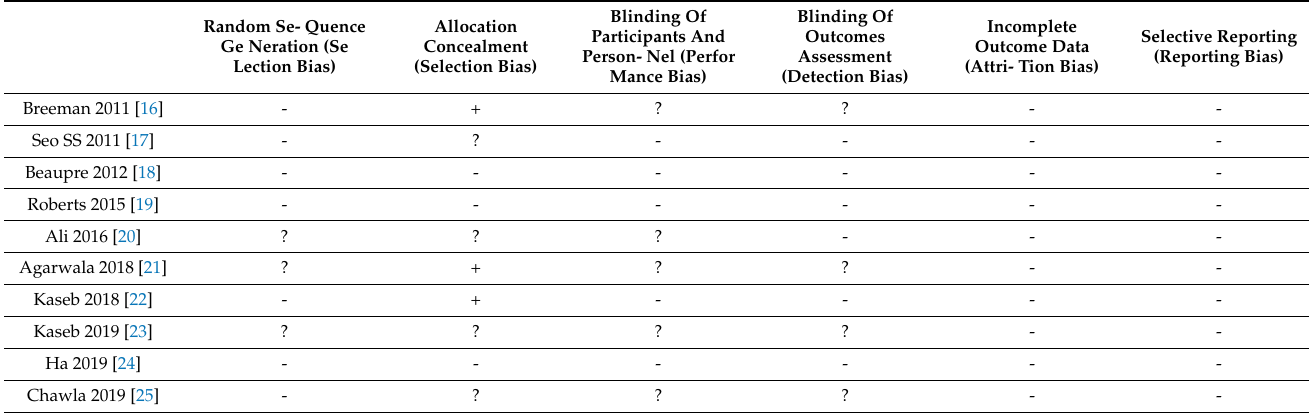
Table 2. Assessment of study bias (red=high bias, yellow=intermediate bias, green=low